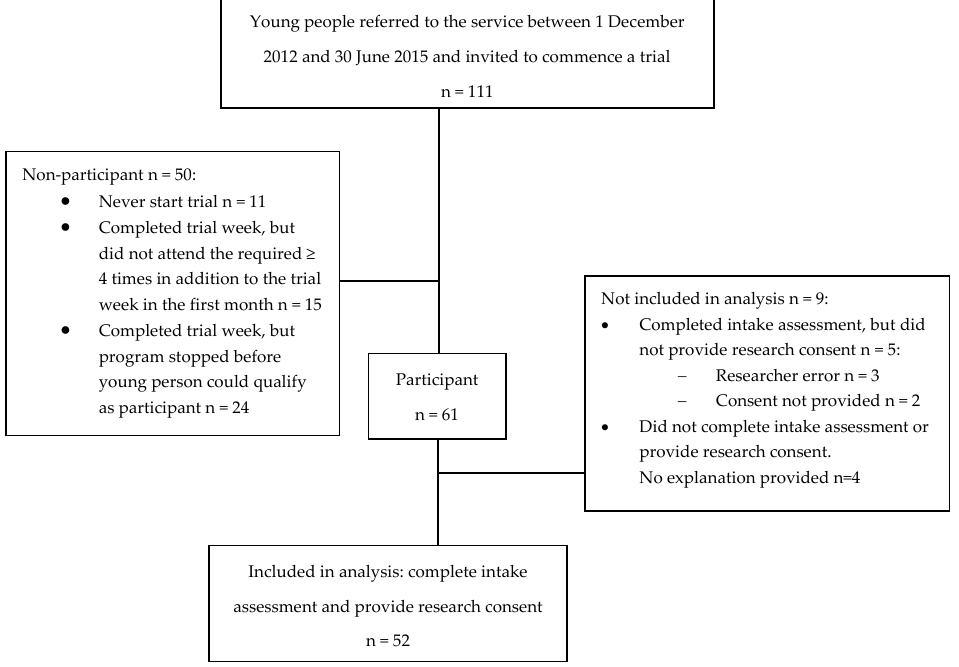
Figure 1. Flow-chart of referral to a service for high-risk young people.